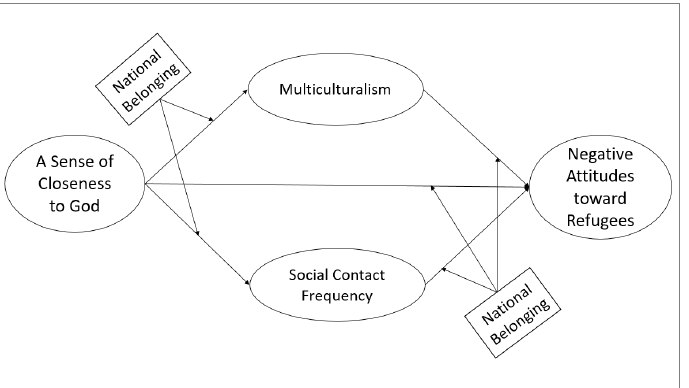
Figure 1. Research conceptual